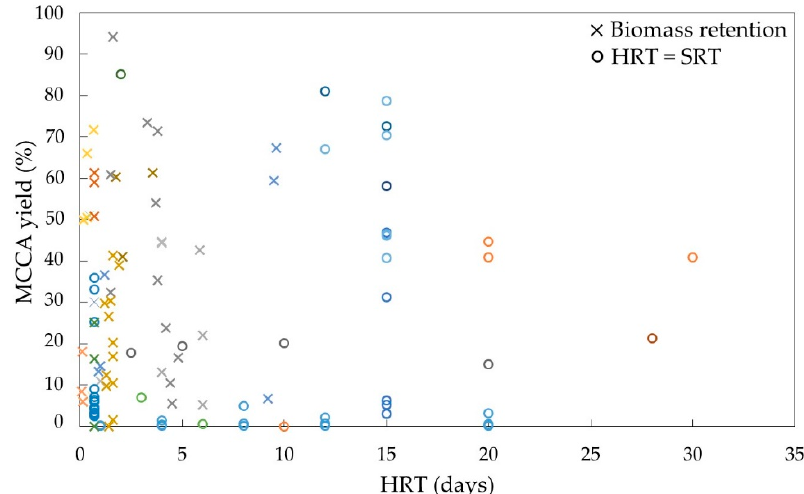
Figure 5. MCCA yield as a function of HRT in 24 studies performing (semi-)continuous experiments of complex or synthetic feedstock. Colours represent experimental results reported within the same study. Estimated values were calculated as reported in Appendix A. Data collected from [23,27,36,37,72,77,88,93–98,100,105,106,110,111,115,123,126–128,173], the full data for the figure can be